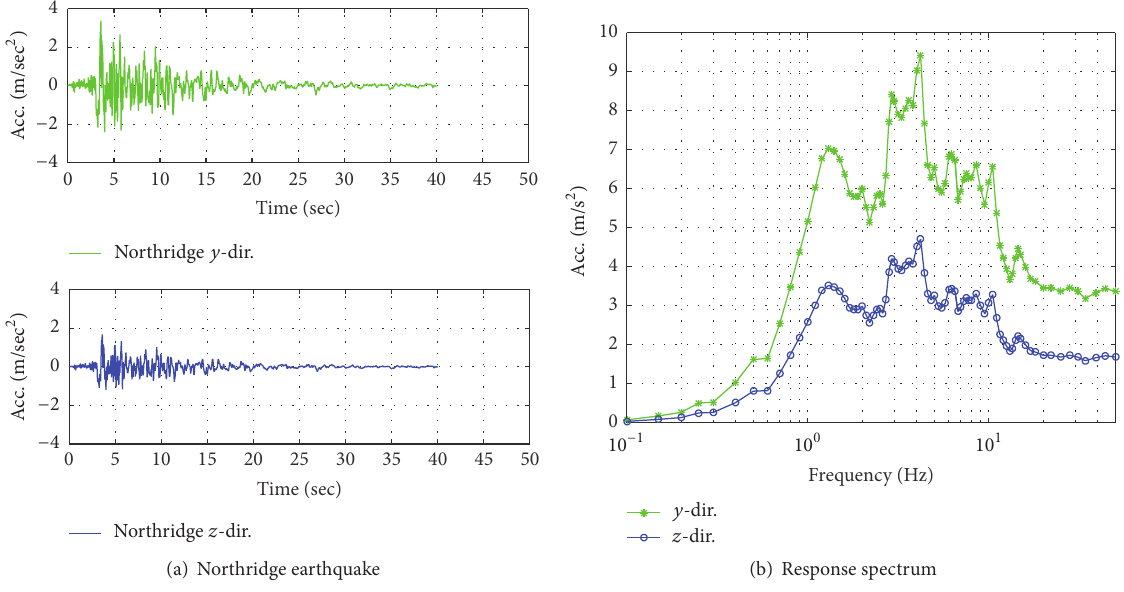
Figure 9: Northridge earthquake and its response